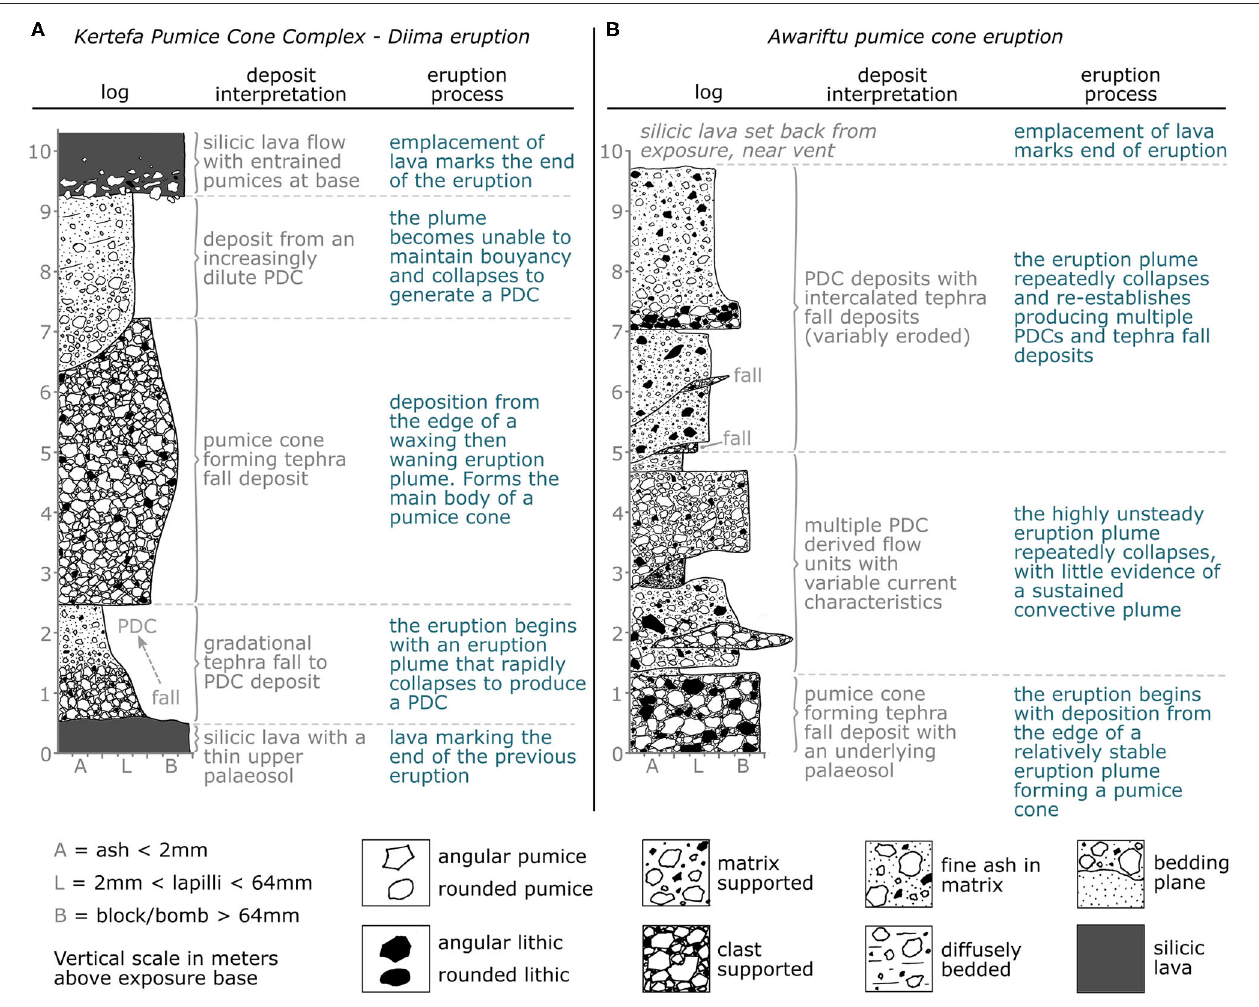
FIGURE 3 | Pyroclastic logs and interpretations from two of the 9 Aluto pumice cones investigated in Clarke (2020). (A) The deposits of the Diima eruption, part of the Kertefa Pumice Cone Complex. (B) Deposits of the Awariftu pumice cone on the northern flank of the caldera. The PDC deposits, and their close association with tephra fall deposits, are consistent with those often produced during eruption column collapse events. Interpretations from these, and the other 7 eruption reconstructions were used to develop the generalized pumice cone eruption scenario depicted in Figure 2